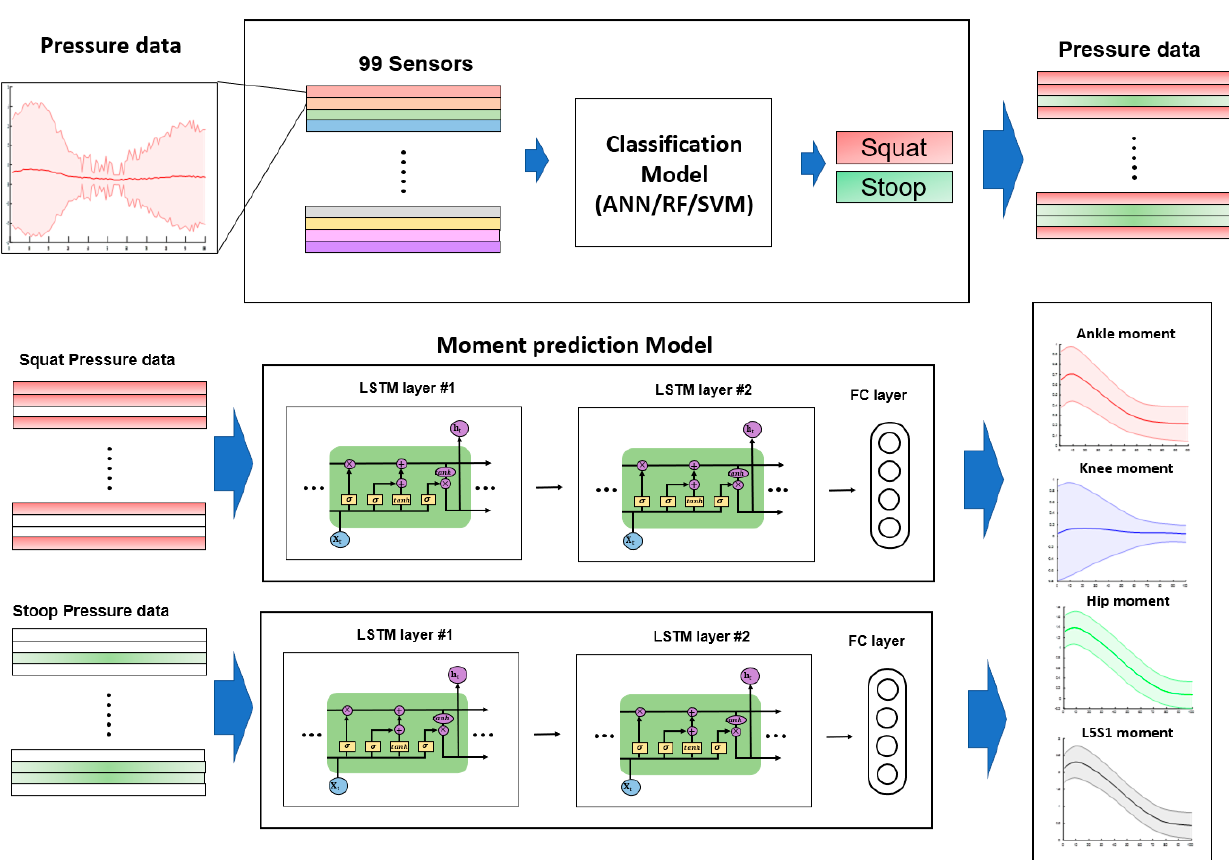
Figure 1. Flow chart of joint moment prediction using insole pressure data developed in this study.